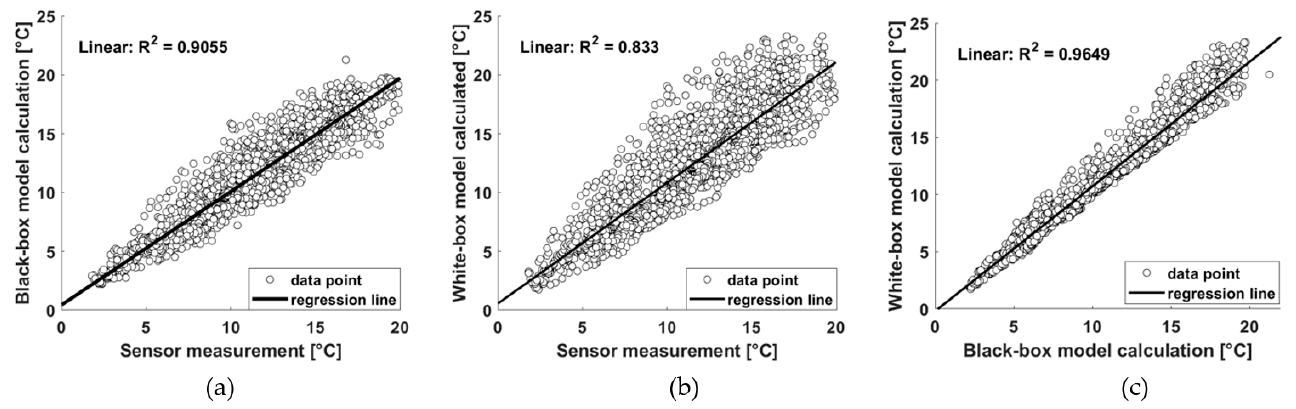
Figure 5. Performance analysis of the investigated models, April 2020: ( a ) Performance of the black-